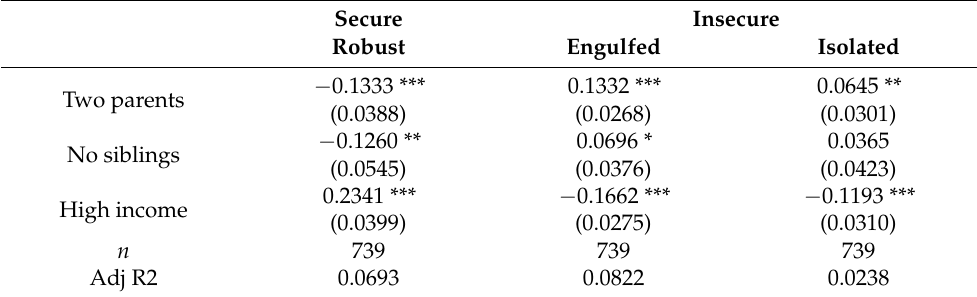
Table 3. Relation between family background and students’